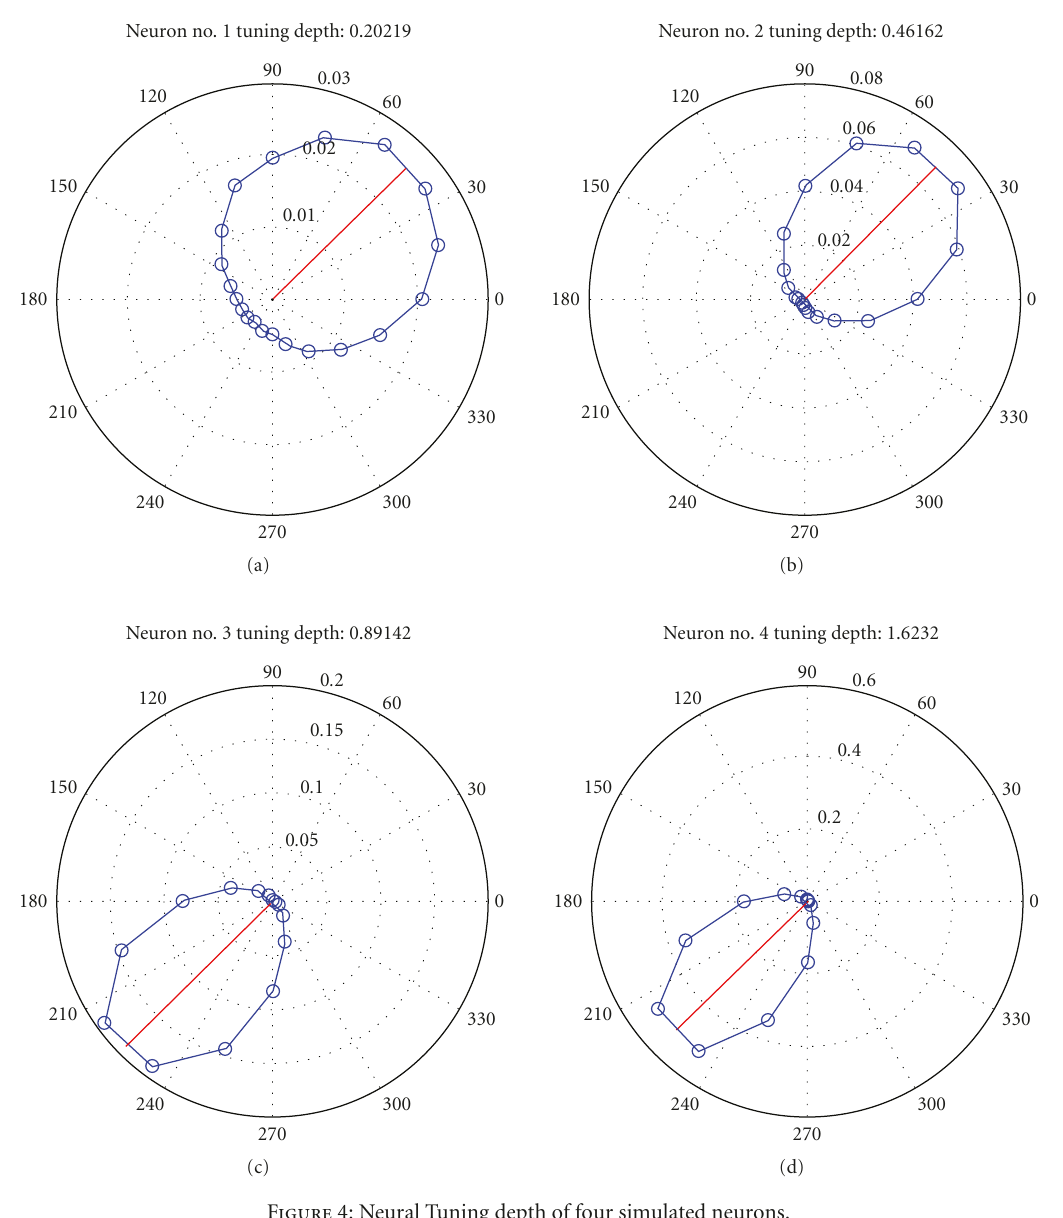
Figure 4: Neural Tuning depth of four simulated